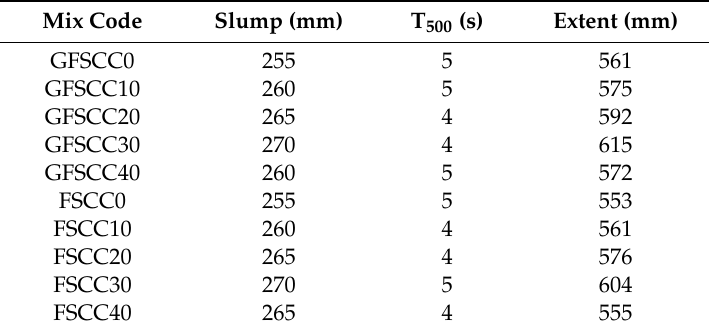
Table 7. Performance indexes of self-compacting